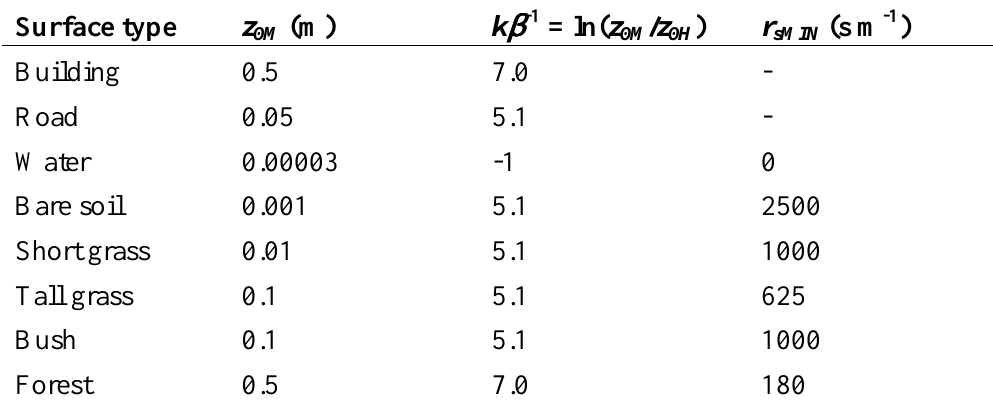
Table 1. Parameters fixed for surface coverage